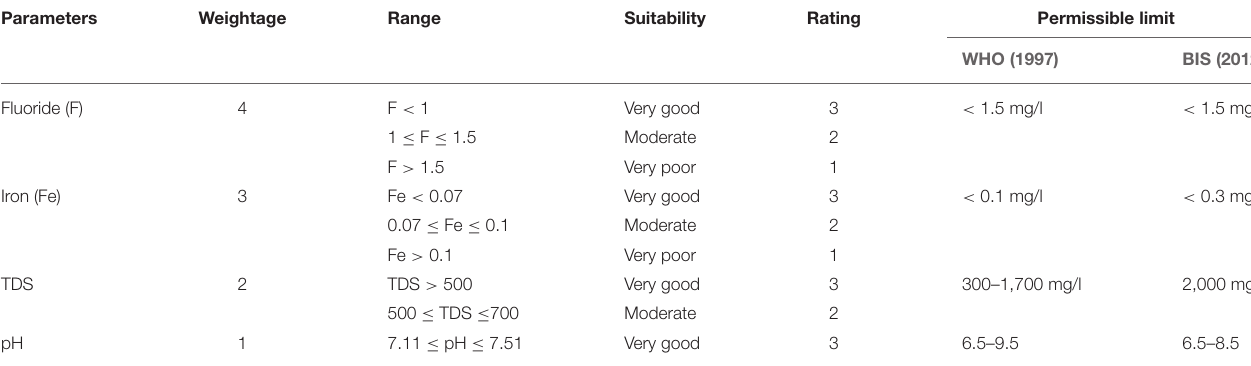
TABLE 1 | Parameterization of groundwater quality